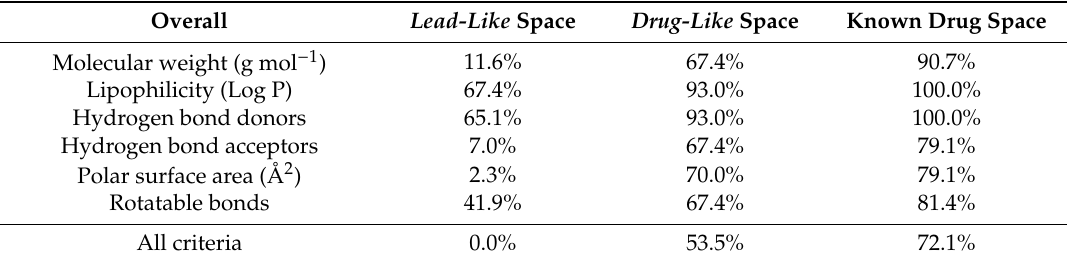
Figure 22. Drug-like compounds isolated from deep-sea Bacteria. Table 5. Compounds from Bacteria and their inclusion within the defined chemical